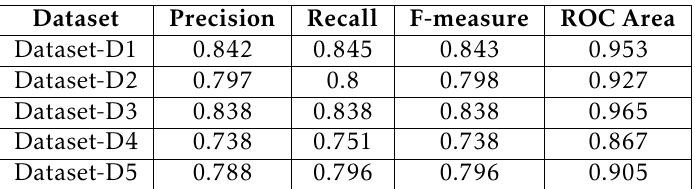
Table 3. The prediction results for Logistic Regression (LR)